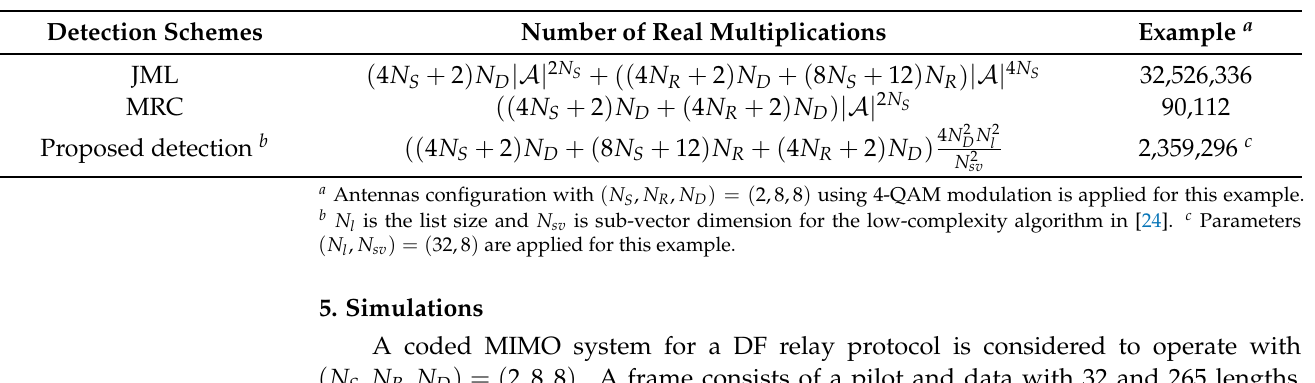
Table 3. Complexity analysis in terms of real